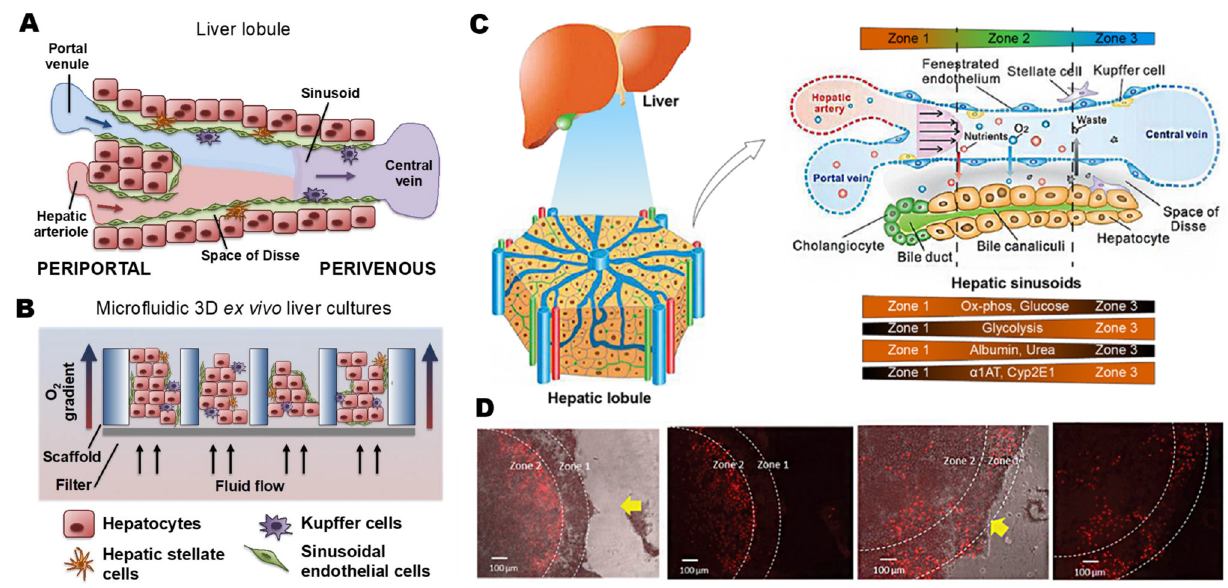
Figure 1. ( A ) Cell distribution structure in a liver lobule. Double blood supply of hepatic arteriole and portal vein enters the liver’s portal triad region and the central vein. ( B ) Three-dimensional liver tissue diagram in LoC. The fluid flows through the pores on the scaffold, providing the biochemical environment and mechanical stimulation. ( C ) Microstructure of liver. The liver lobule is hexagonal, with a 1 mm diameter and a 2 mm thickness, functionally divided into three regions. ( D ) Example of zonal heterogeneity of hepatotoxicity. The yellow arrow shows the flow direction. ( A , B ) reproduced with permission of [34], Copyright © 2017. Published by Elsevier. ( C , D ) reproduced with permission of [29] , Copyright © 2019. Published by MDPI.